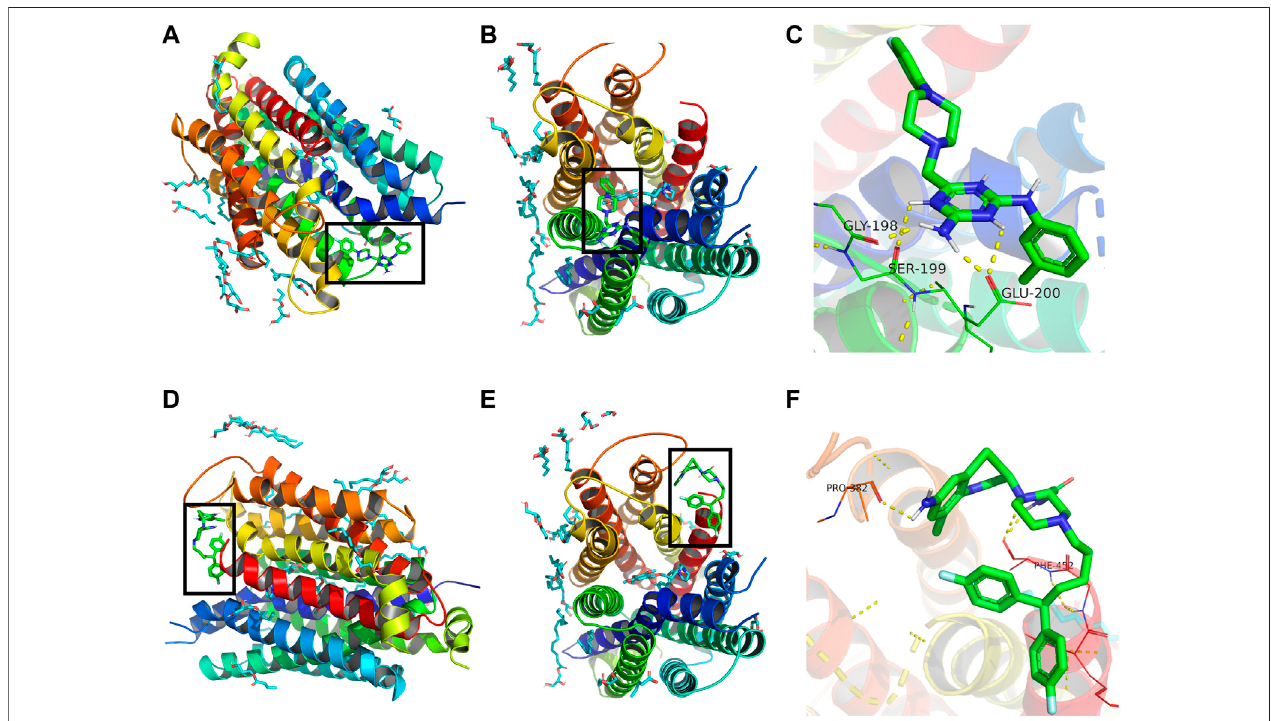
FIGURE 7 | Molecular docking analysis of compound 3c against ENT1. 3D structural overview of ENT1 with (A,B) compound 3c and (D,E) dra fl azine docked complexes. The black box showed the location of compound 3c. A close-up of the docked protein displaying the amino acid residues of ENT1 involved in the binding with (C) compound 3c and (F) dra fl